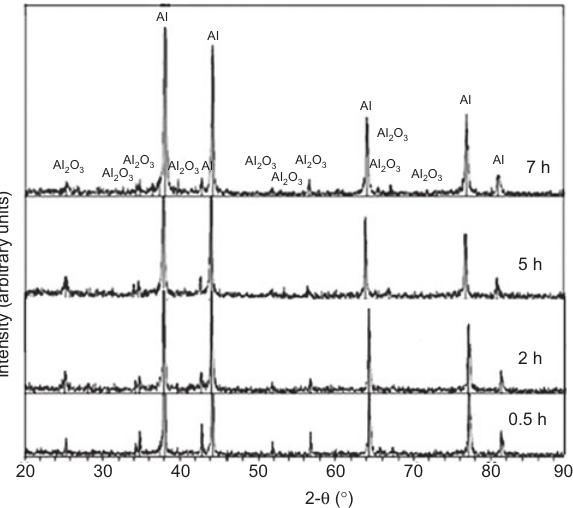
Figure 8 XRD patterns of the Al-10 vol. % Al der after 0.5, 2, 5 and 7 h of